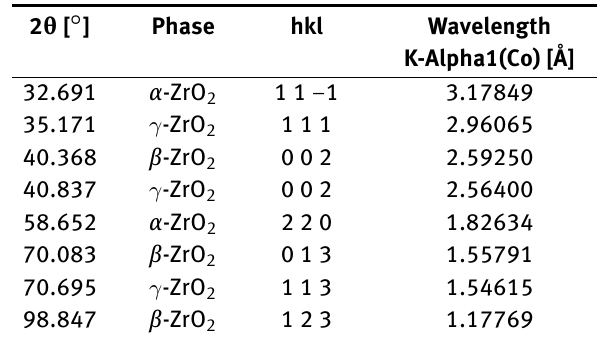
Table 4: Phase composition analysis of the sample after